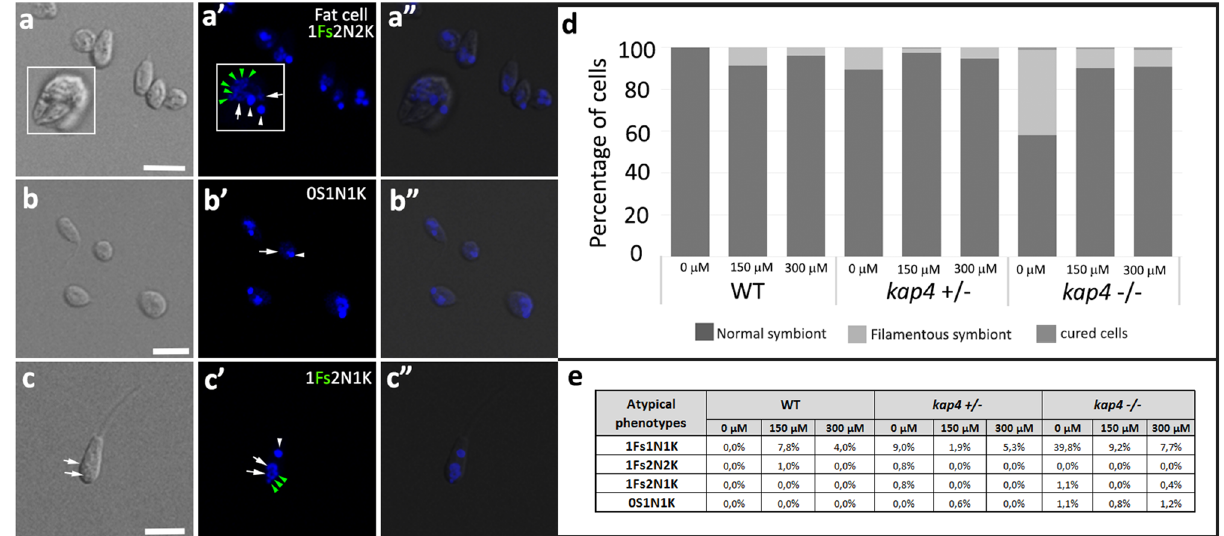
Figure 6. DAPI-stained mutant protozoa presented different atypical phenotypes when compared to WT cells after treatment with cisplatin for over 24 h ( a – c ). ( a – a ″ ) WT cells treated with 150 µM cisplatin presented rounded shapes, and the fat cell phenotype contained a symbiont with multiple nucleoids (white square, green arrowheads). ( b – b ″ ) Ad kap4 (+⁄−) cells treated with 300 µM cisplatin lacking the symbiont. ( c – c ″ ) Ad kap4 (−⁄−) cells treated with 300 µM cisplatin containing one filamentous symbiont, two nuclei and one kinetoplast. ( d ) Counting of cellular patterns considering the presence of normal or filamentous symbionts. ( e ) Percentage of cells with atypical phenotypes. Bars 5 μm. Fs Filamentous symbiont., N nucleus—white arrows; K-kinetoplast— white arrowheads. A total of 1000 cells of WT and KAP4 mutant cells were counted in 3 independent